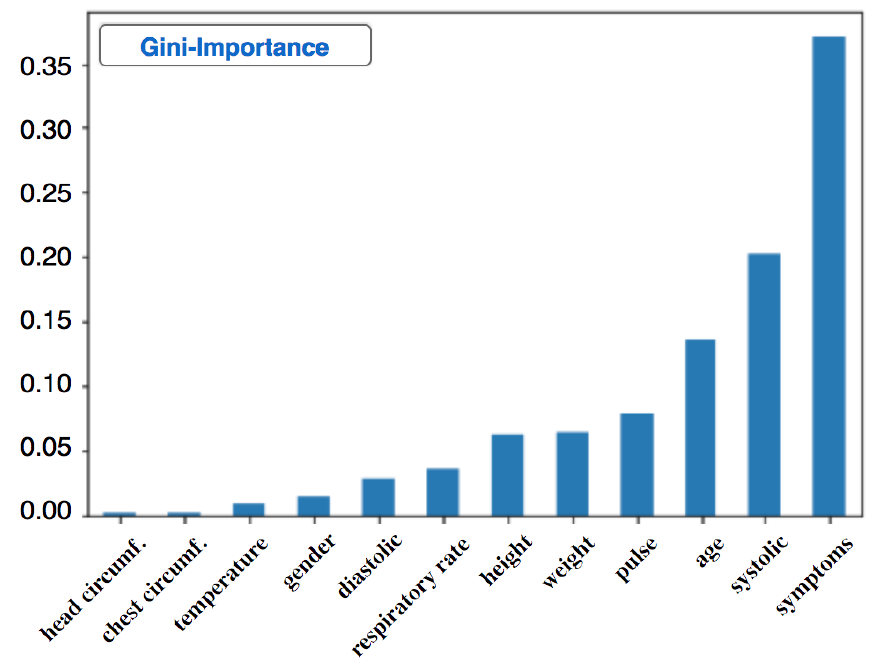
Figure 8. Feature importance in predicting high blood pressure.